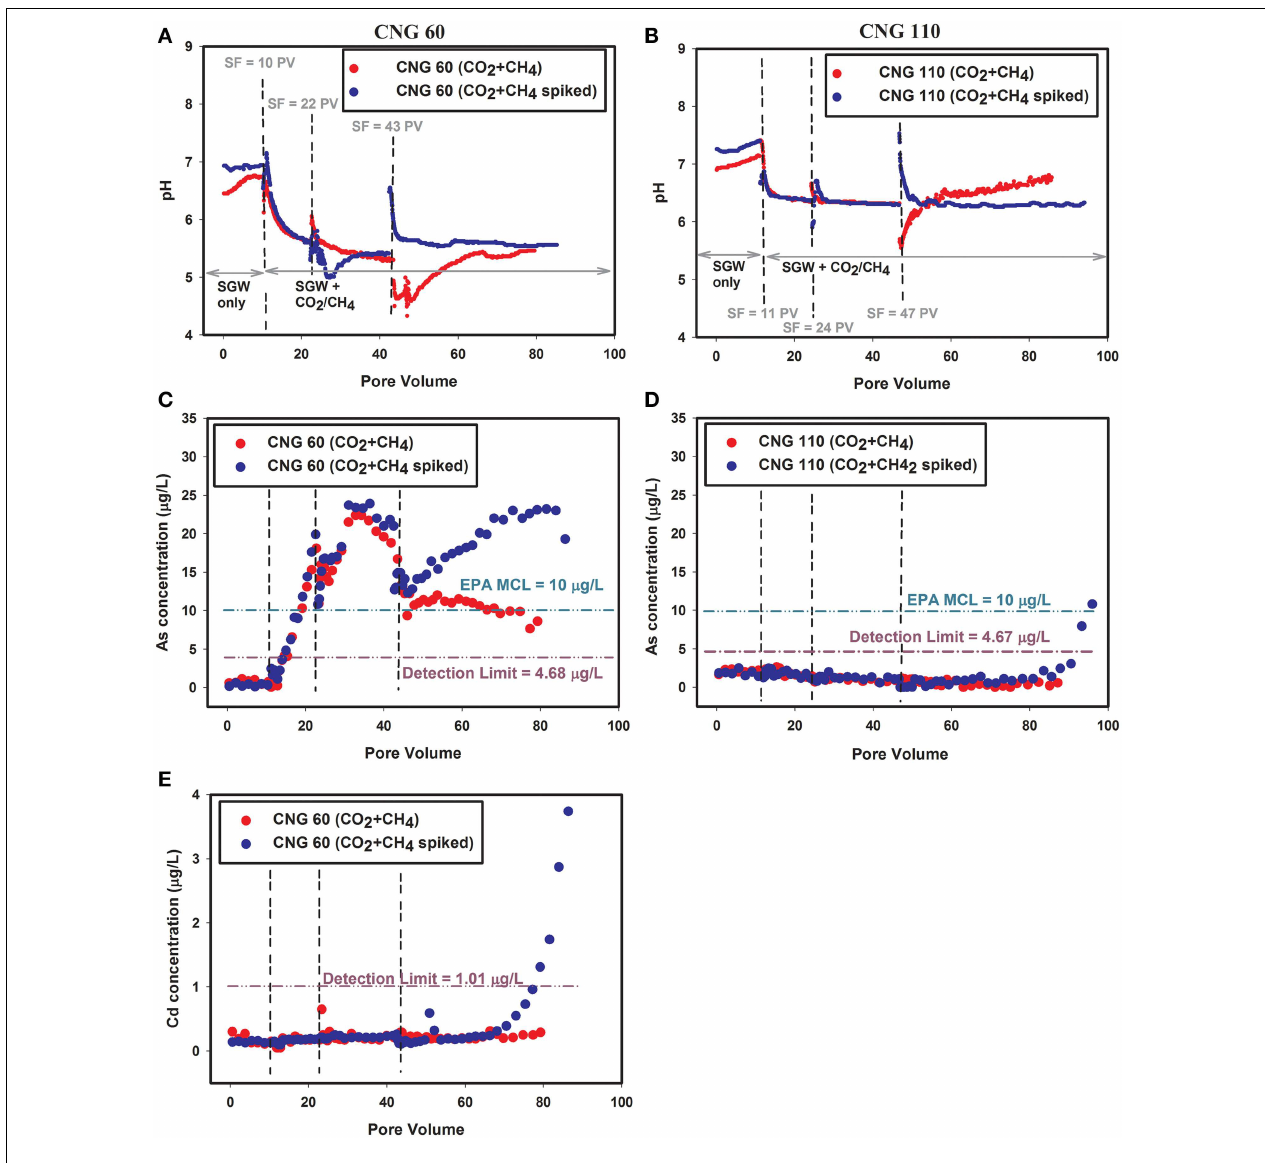
FIGURE 3 | Column study results: pH (A,B) and concentration of As (C,D) and Cd (E). Red represents columns with the control SGW injected with CO 2 /CH 4 ; blue represents the As/Cd spiked SGW injected with CO 2 /CH 4 . CNG 60 columns are on the